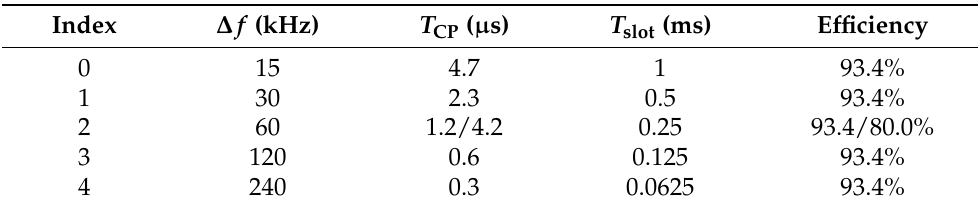
Table 1. Numerology structure in 5G.